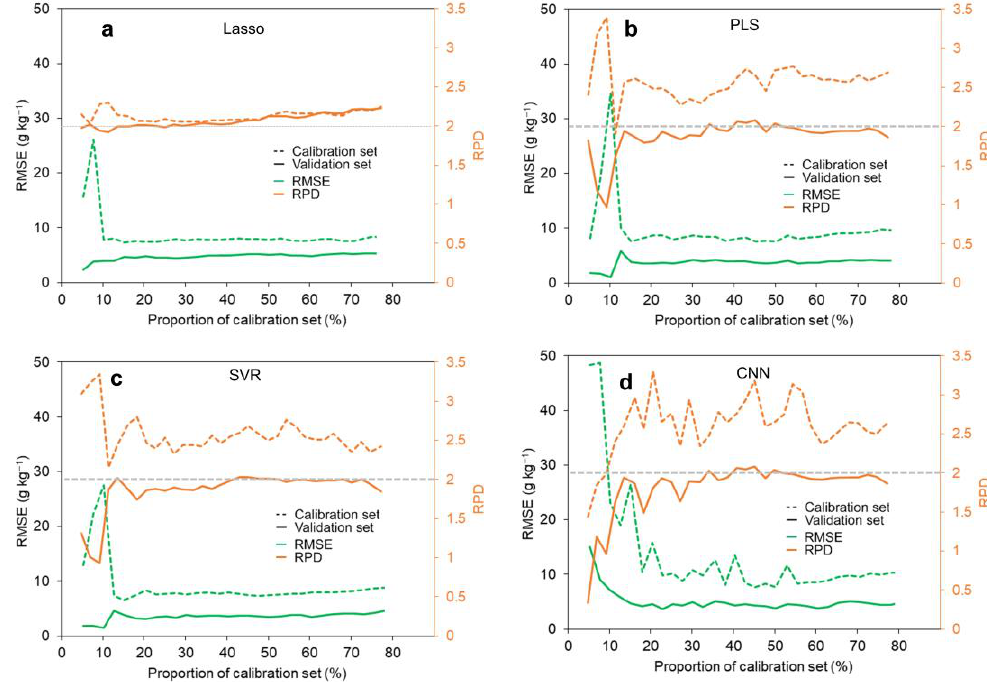
Figure 4. The root mean squared error (RMSE) and residual predictive deviation (RPD) were computed based on different calibration sizes in Lasso ( a ), partial least squares (PLS, ( b )), support vector regression (SVR, ( c )), and convolutional neural network (CNN, ( d )) models.